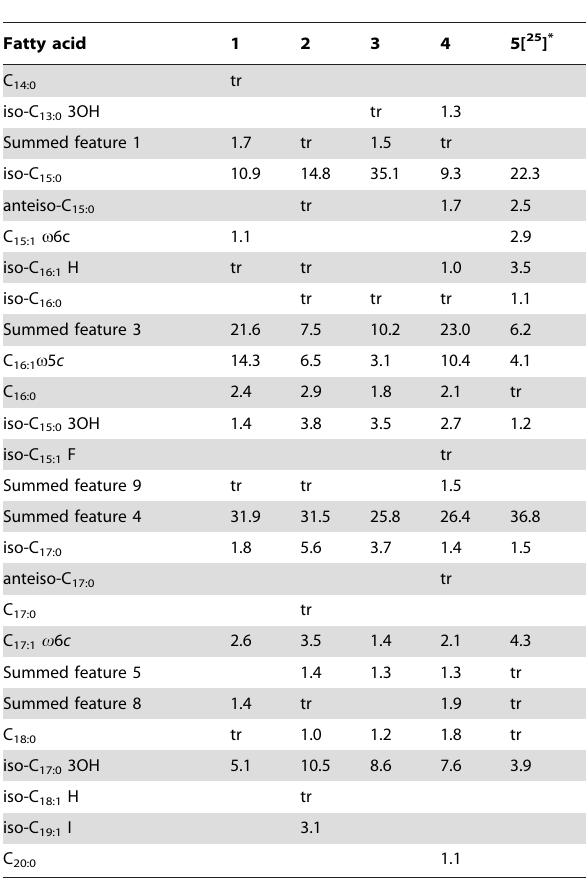
Table 1. Fatty acid profiles (%) of the strain H4X T and related type strains of the genus Pontibacter